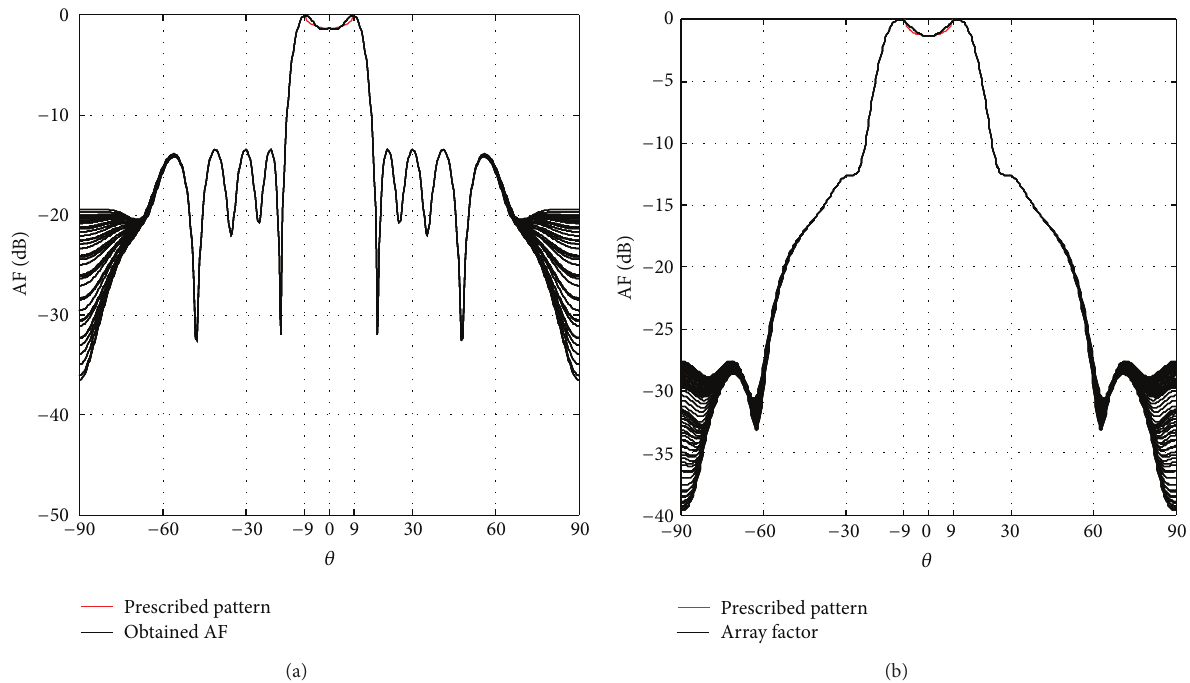
Figure 3: Isoflux radiation for GEO satellites: (a) uniform excitation and (b) concentric